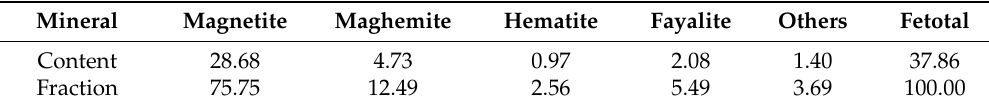
Table 2. The distribution of iron in associated minerals (wt %).